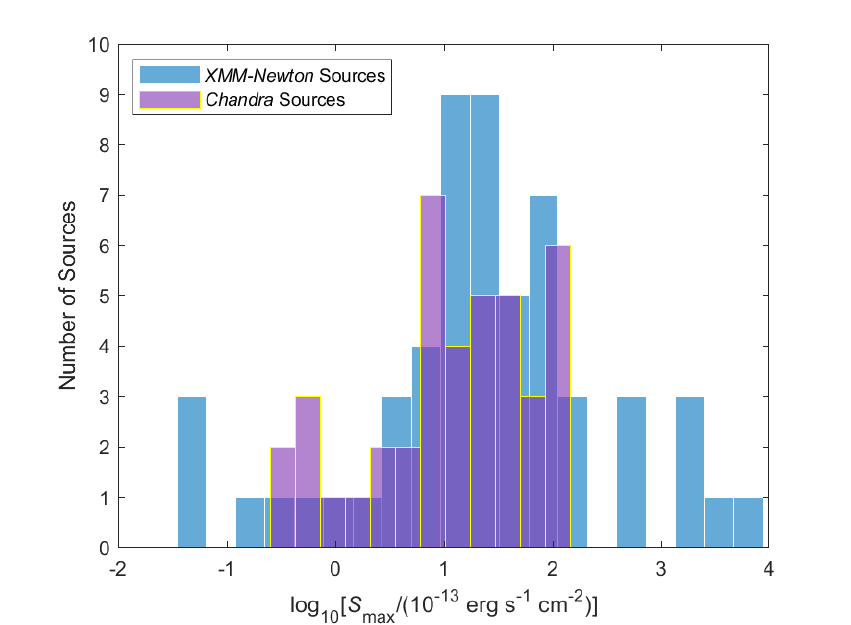
Figure 2. Flux histograms. The SMC XMM-Newton and SMC Chandra data sets appear to be quite similar. In particular, both histograms show secondary peaks in the tails of the